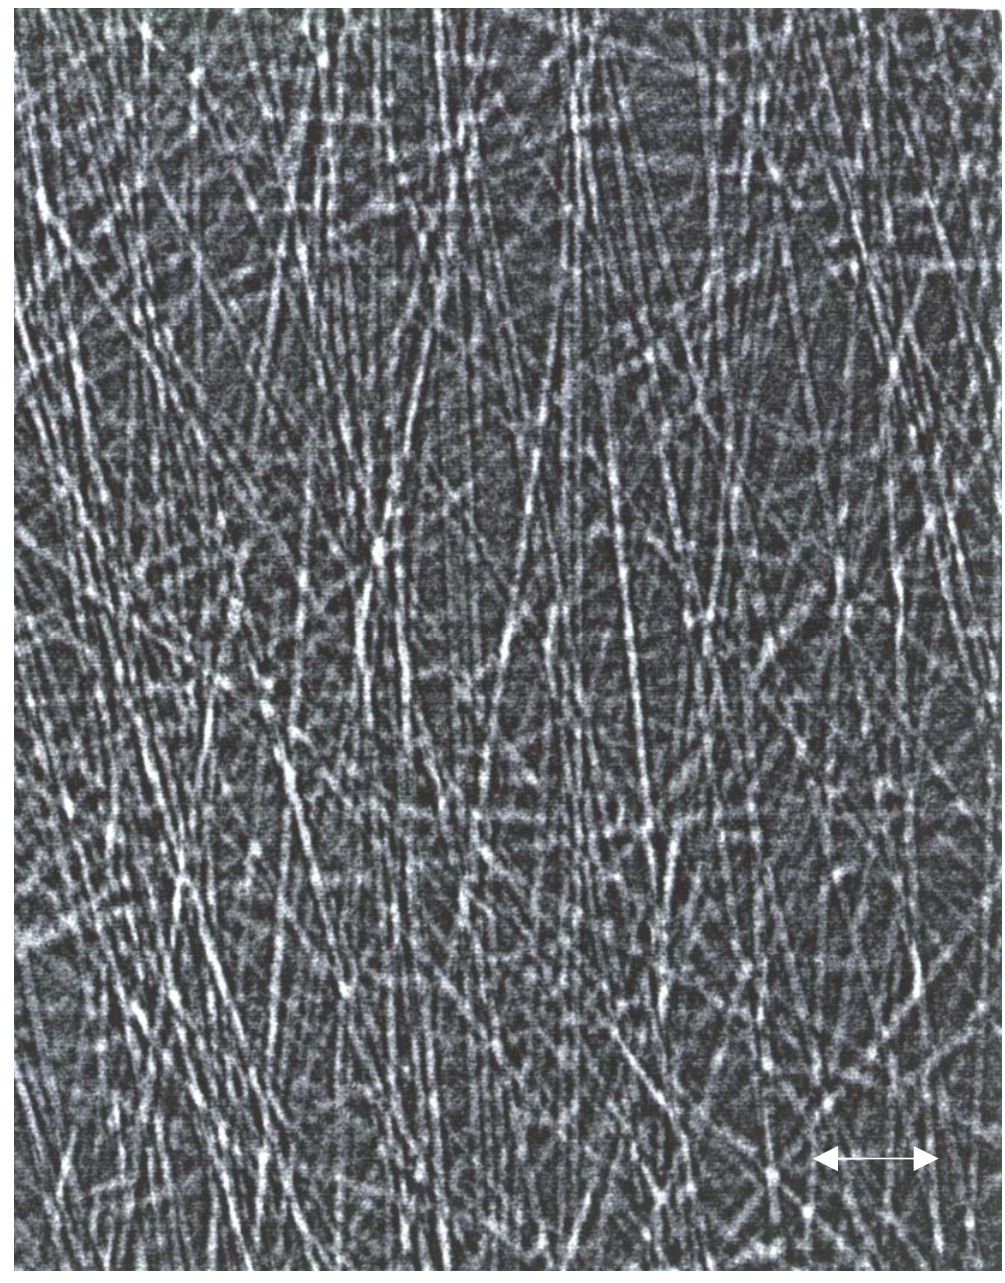
Figure 4. PCX image of a Toray carbon-paper sample (approximately 100 μ m thick): 30 kVp, 40 μ A; source-to-sample distance = 10 cm; sample-to-detector distance = 190 cm; exposure time 200